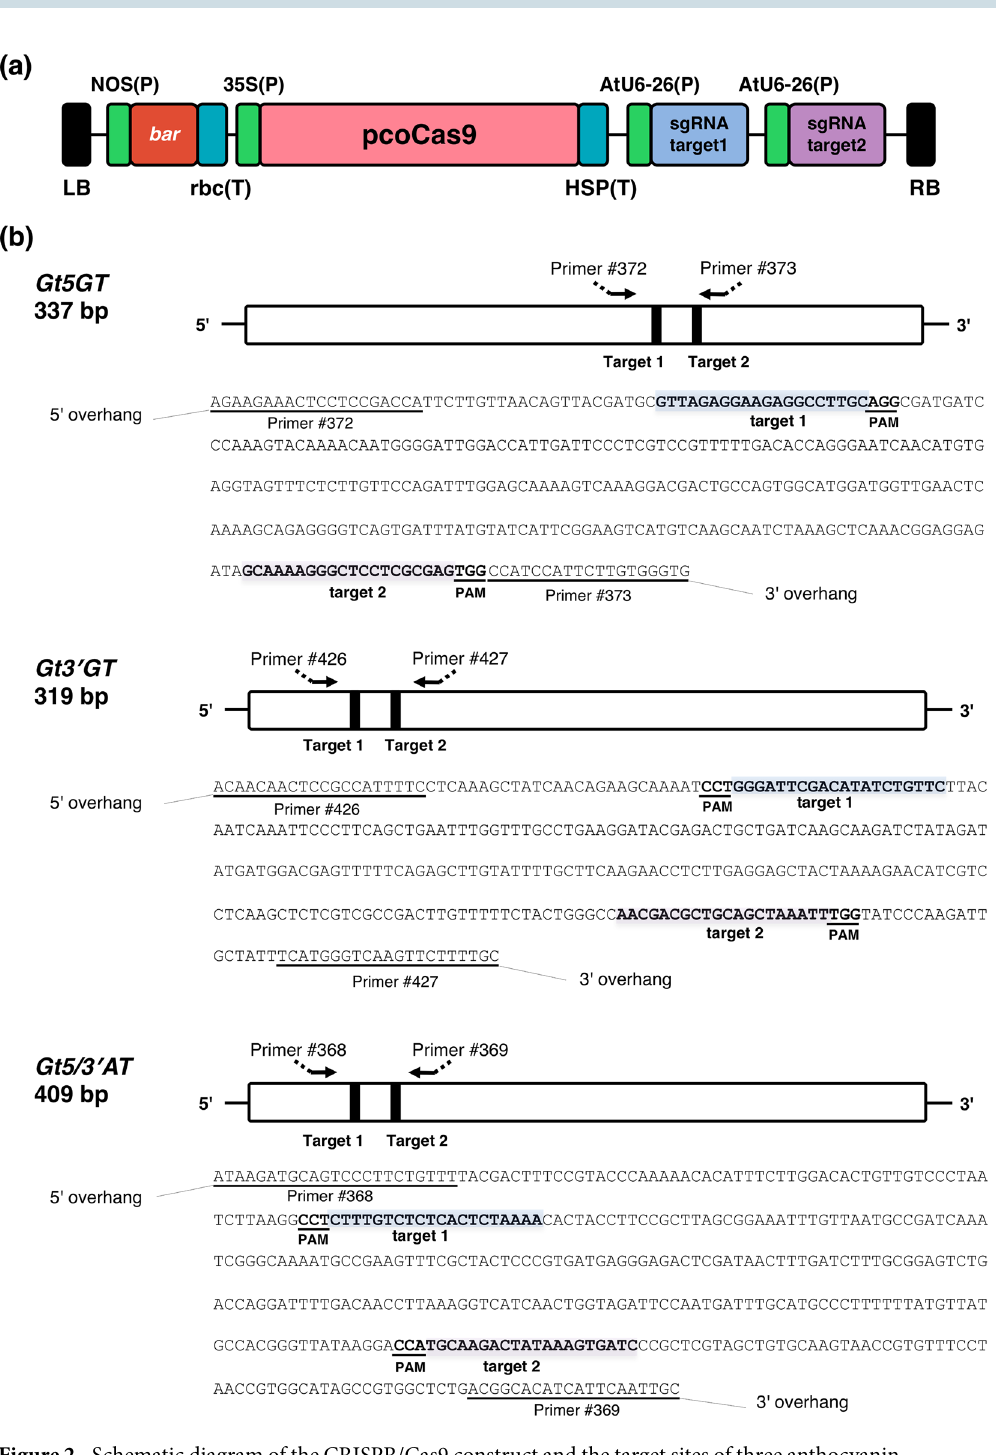
Figure 2. Schematic diagram of the CRISPR/Cas9 construct and the target sites of three anthocyanin modification genes. ( a ) Schematic diagram of the T-DNA region of the CRISPR/Cas9 binary vector carrying pcoCas9, which is a codon-optimized Cas9 for plants. Two sgRNA expression cassettes are tandemly aligned. ( b ) Schematic diagrams of the Gt5GT , Gt3 ′ GT , and Gt5/3 ′ AT genes and their sequences, including the sequences of the amplified regions. Shaded boxes represent targets 1 and 2, whereas PAM refers to the protospacer adjacent motif (NGG). The primers used for the PCR amplification or direct sequencing are